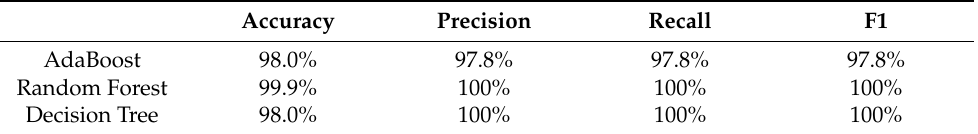
Table 2. Activity monitoring performance of different classifiers with proposed